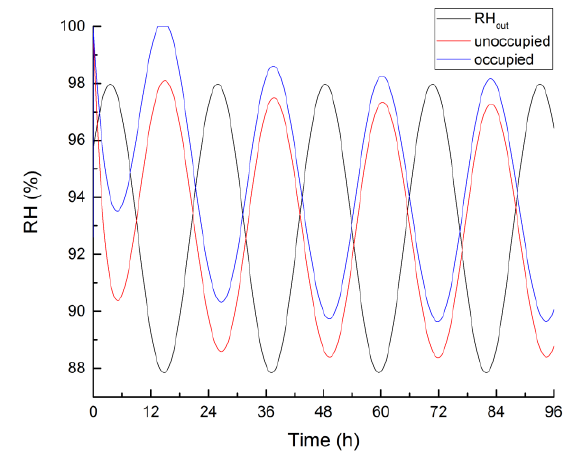
Figure 6. Diurnal variation of outdoor and indoor air RH.